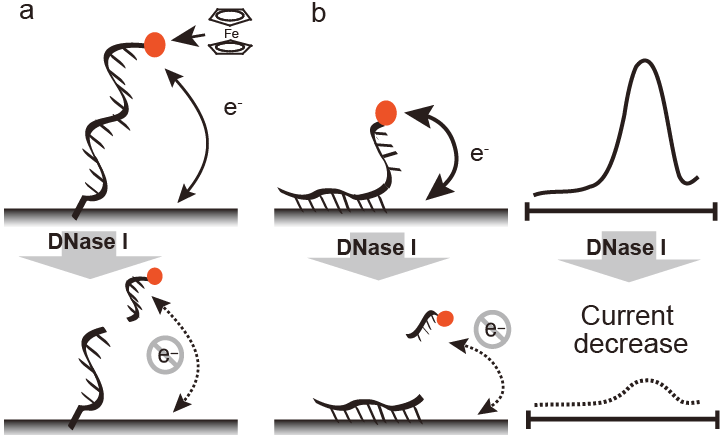
Figure 4. Nuclease detection by a ferrocene-modified oligonucleotide immobilized to an electrode through an Au-S linkage ( a ) and reaction of a cytosine oligonucleotide with activated ester-immobilized electrode ( b ). Current intensities at both electrodes decrease upon digestion with DNase